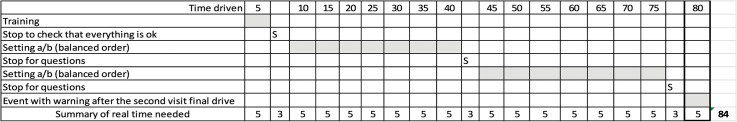
The “protocol” for the driver.